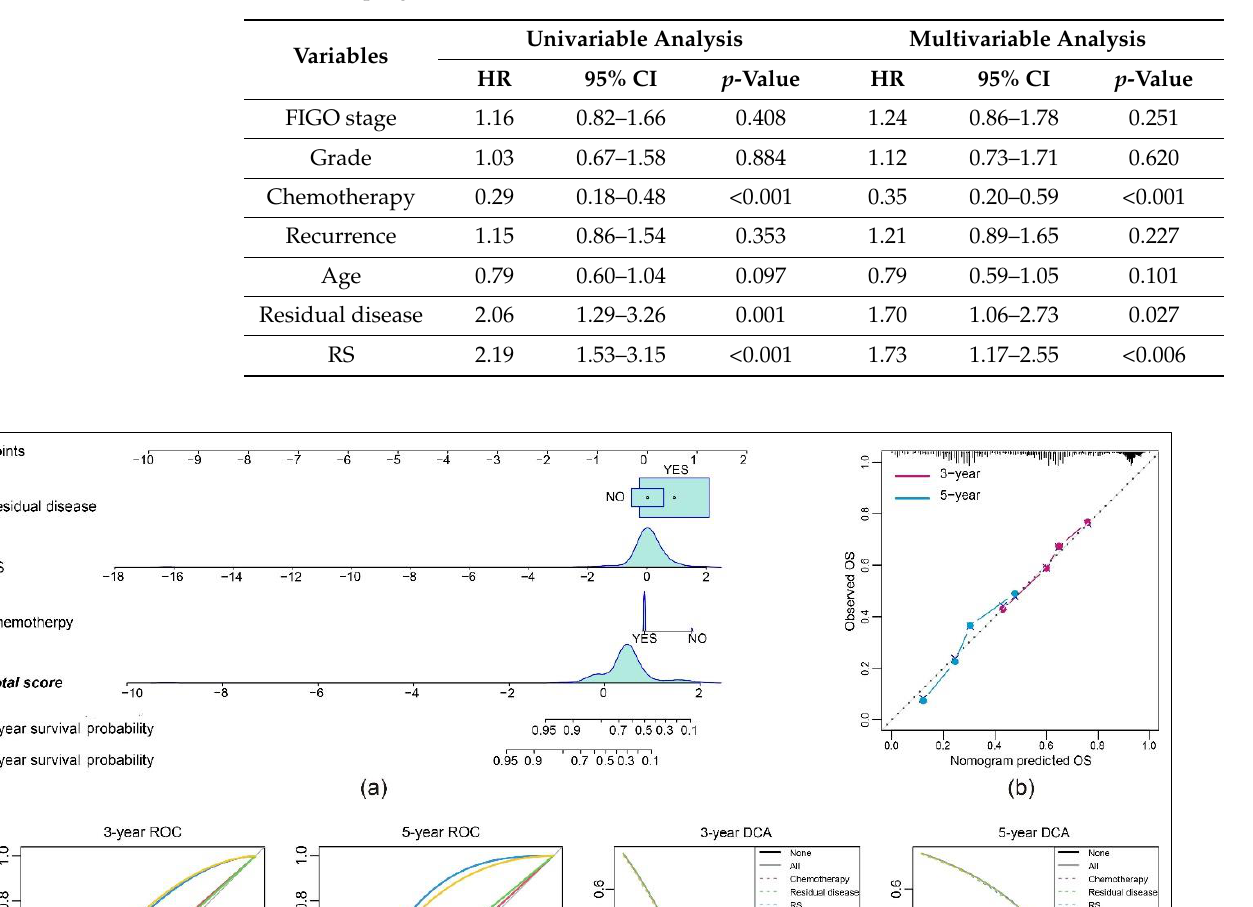
Table 3. Univariable and multivariable Cox regression to analyze the relationship between the RS and clinical prognosis.